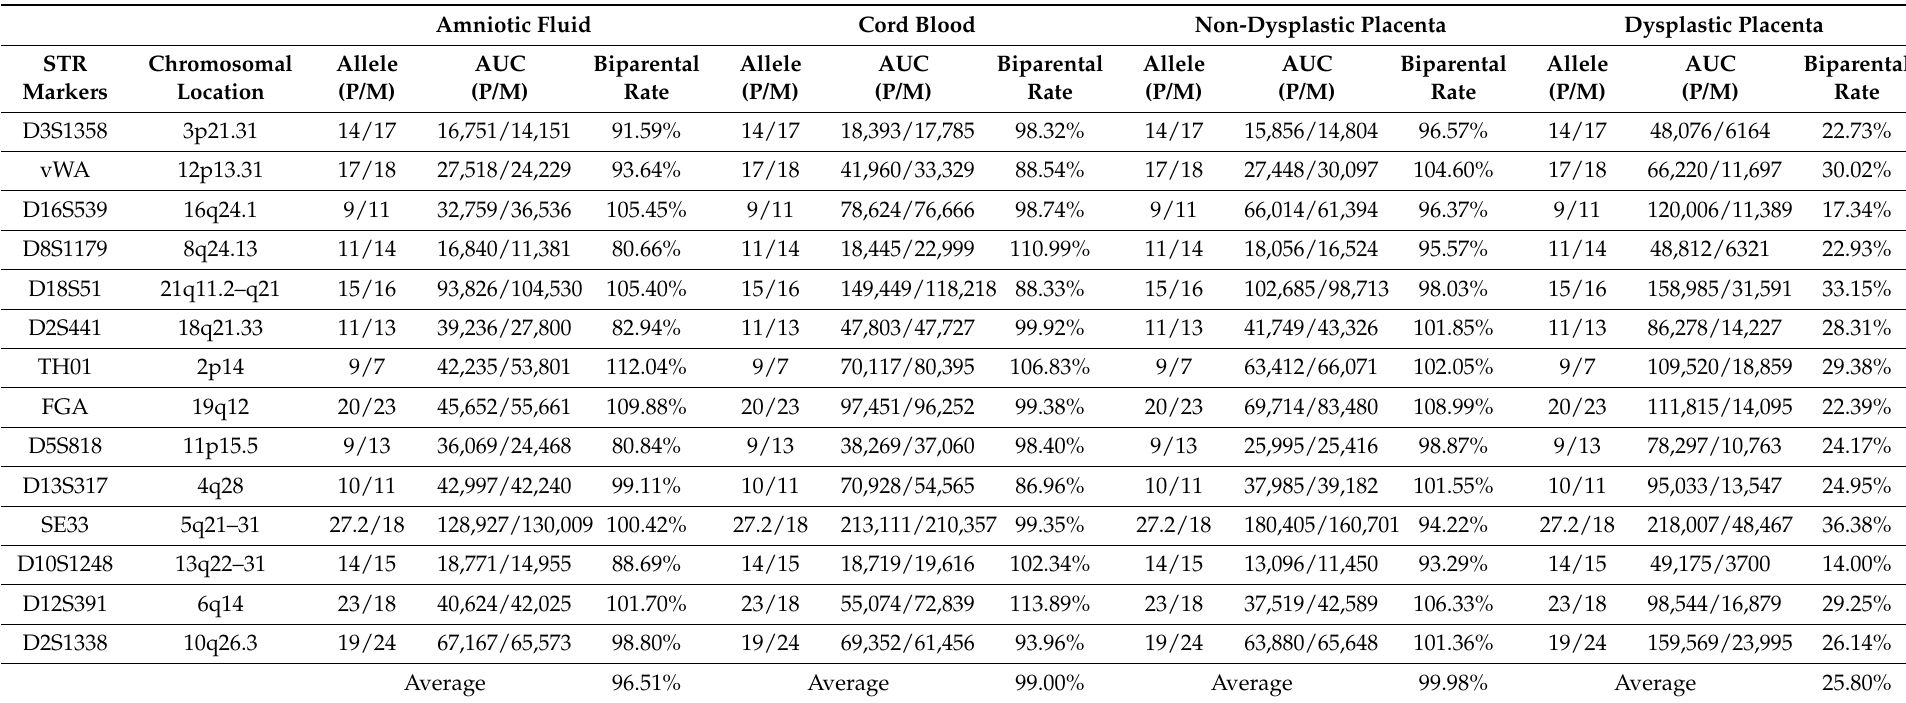
Table 2. Mosaic analysis of androgenetic/biparental cell lines using STR markers from autosomal